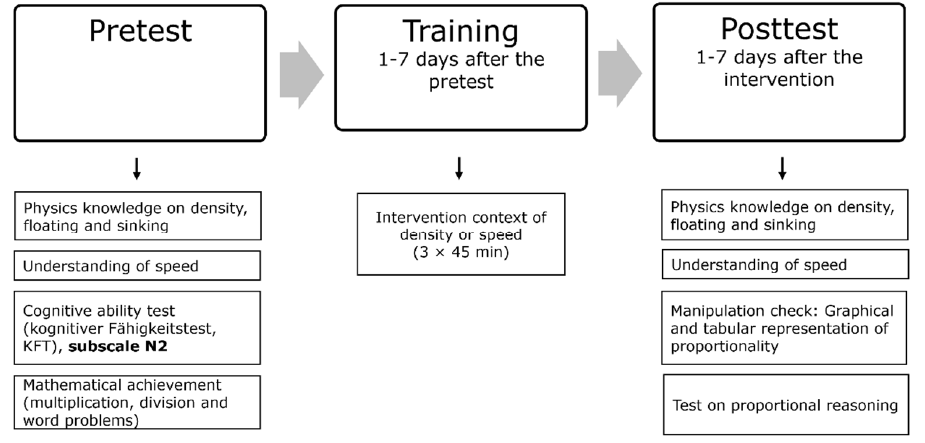
Figure 1. Schedule and overview of tests and the